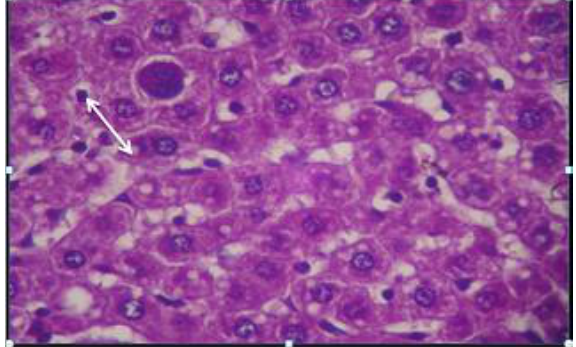
Figure,9: Photomicrographs showing histology of liver tissue from group T3 showed proliferation of kupffer cell accompanied with appearance of megakaryocyte in hepatic parenchyma (H/E X40).